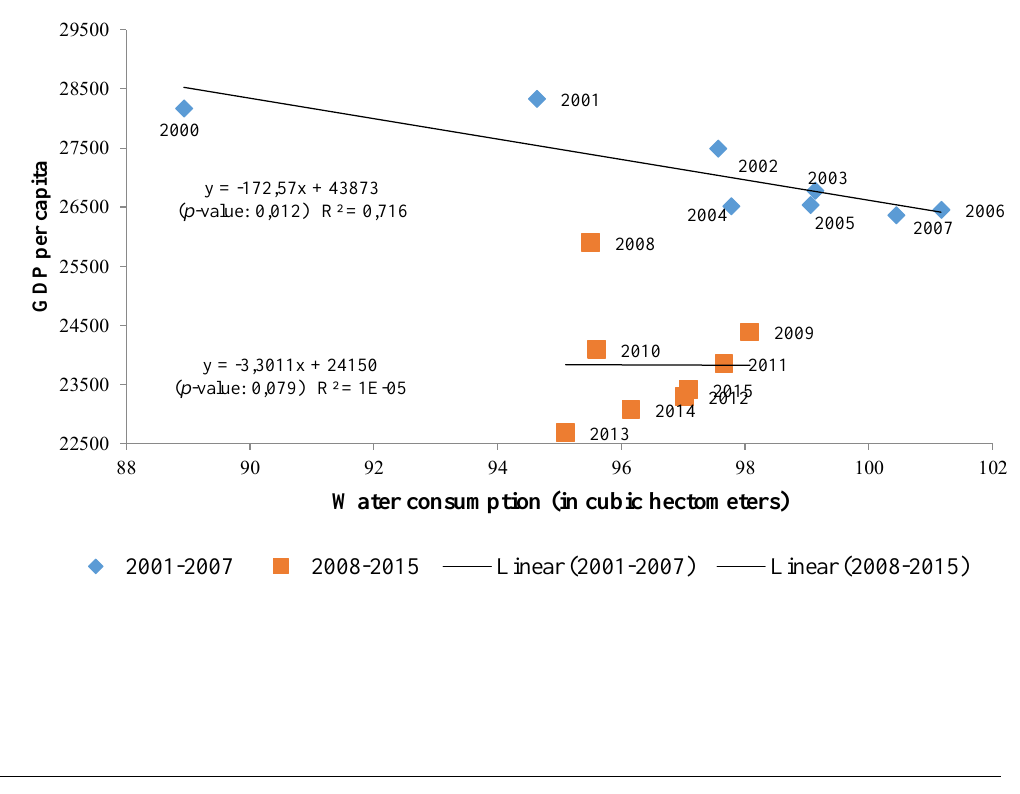
Figure 1: Linear Regression between Water Consumption (in cubic hectometer) and GDP per